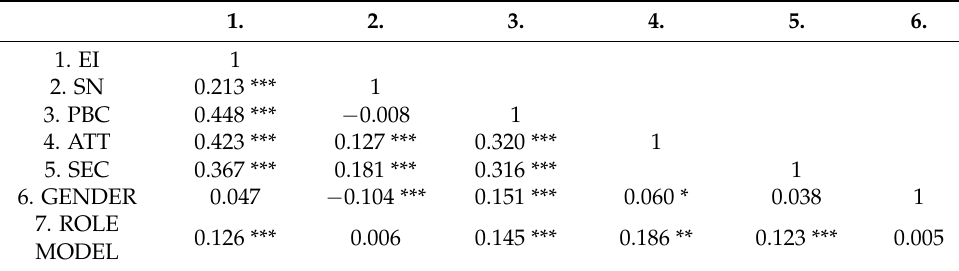
Table 2. Correlations between study